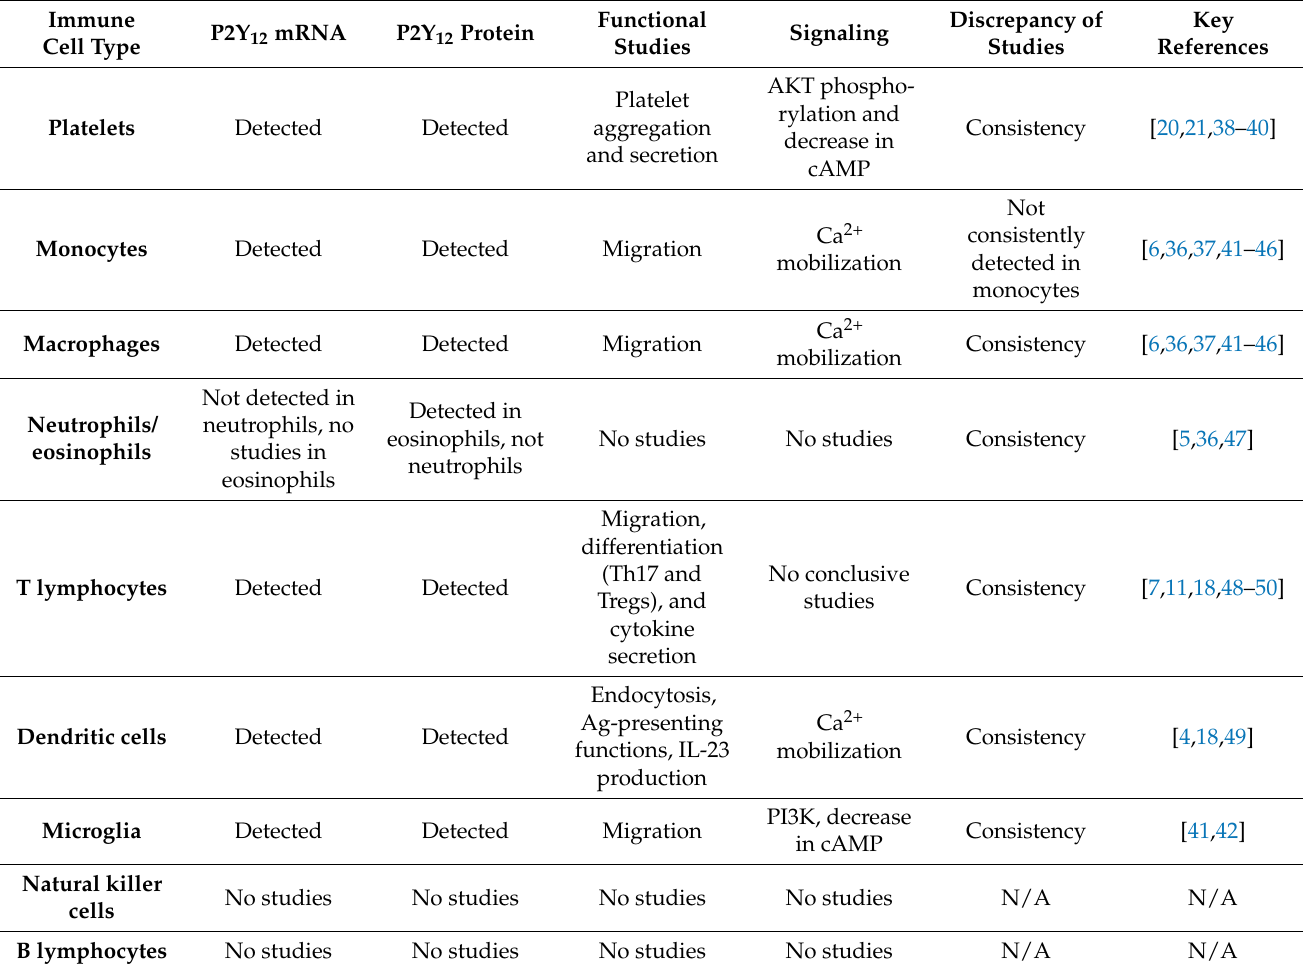
Table 1. P2Y 12 activation in immune